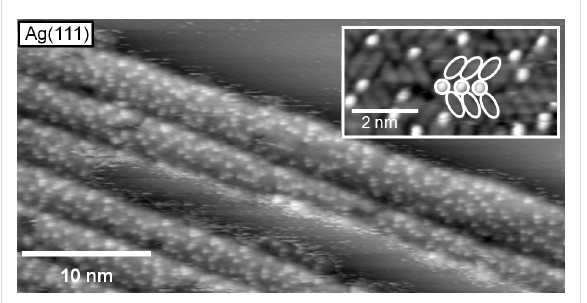
Figure 2: STM image of a submonolayer film of [BMP][TFSA] adsorbed on Ag(111); the narrow terraces of the surface are covered with IL islands in the 2D glass phase, the inset shows a high resolu- tion image of the 2D glass structure resolving both the round shaped and the longish protrusions (marked with white circles and ellipsoids) ( T = 135 K, U T = − 1.14 mV, I T = 100 pA).